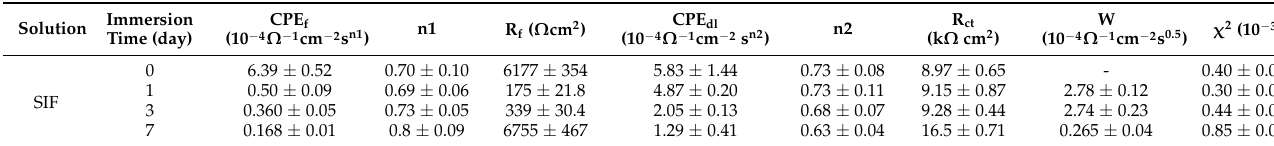
Table 2. Fitting data of EIS for Zn–0.4Li after immersion in SGF for different times. Table 3. Fitting data of EIS for Zn–0.4Li after immersion in SIF for different times. Solution